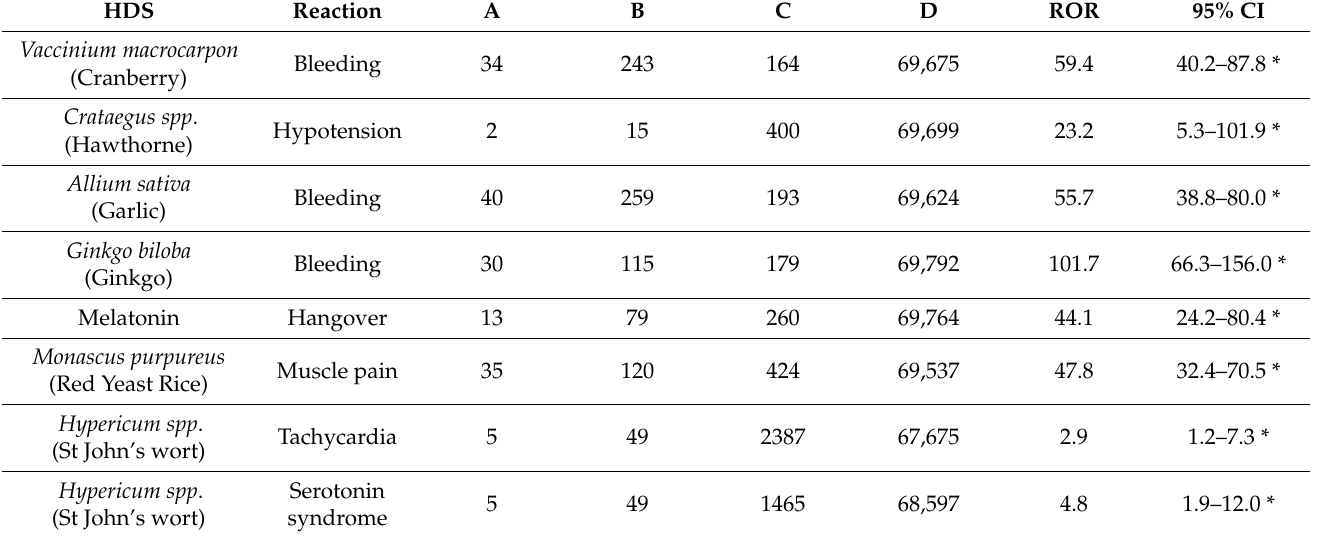
Table 3. Disproportionality analysis for HDS with reaction of interest. A: Number of reactions of interest in those exposed to herb of interest; B: Number of other types of reactions reported for herb of interest; C: Number of reactions of interest reported without herb of interest; D: Number of other types of reactions reported without herb of interest. ROR reporting odds ratio = AD/BC; CI confidence interval, * statistically significant at alpha 0.05.